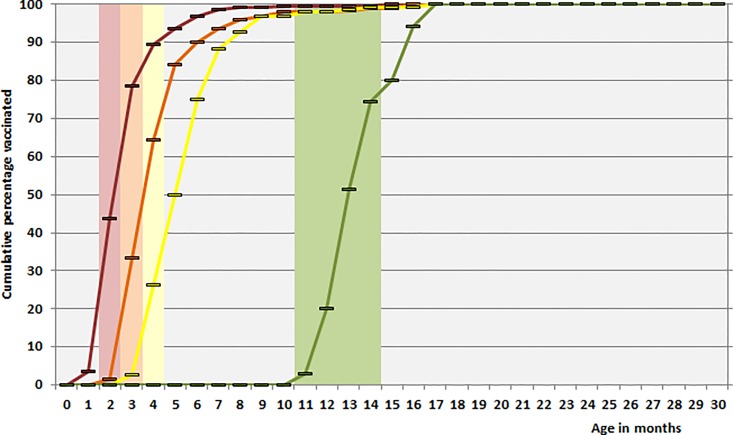
Timeliness of pneumococcal conjugate vaccination (PCV13) of children under two years of age with IPD in Germany (July 2010 –June 2015).Bars indicate scheduled vaccination times, lines indicate cumulative actual vaccination rates in percentage (red: 1st dose, orange: 2nd dose, yellow: 3rd dose, green: booster dose). Only doses given before the time of infection were taken into consideration.